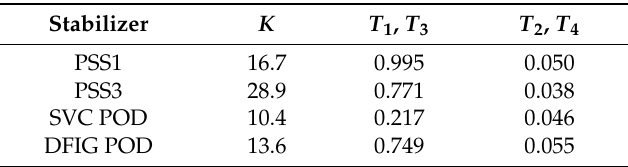
Table 6. The oscillation modes with PSSs and PODs.